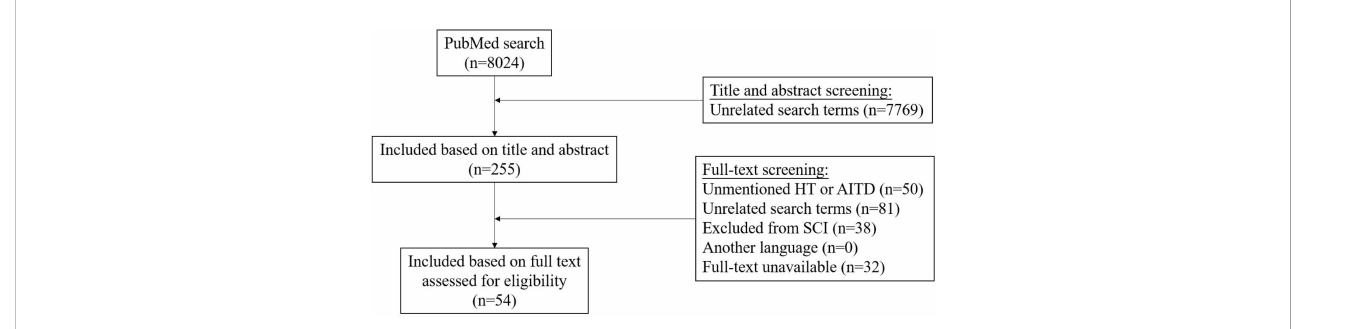
FIGURE 1 Flowchart illustrating the results of the literature-search performed in this systematic